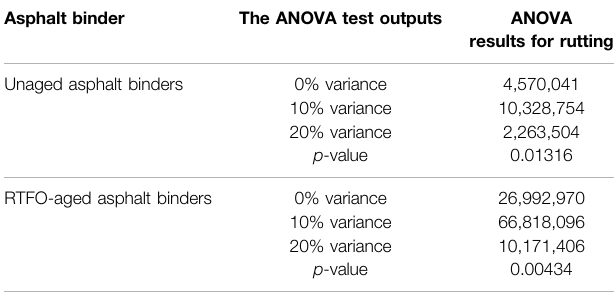
TABLE 2 | One-way ANOVA test